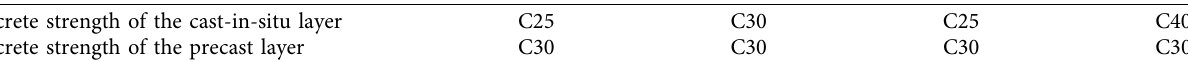
Table 2: List of concrete strength changes in the cast-in-situ layer.